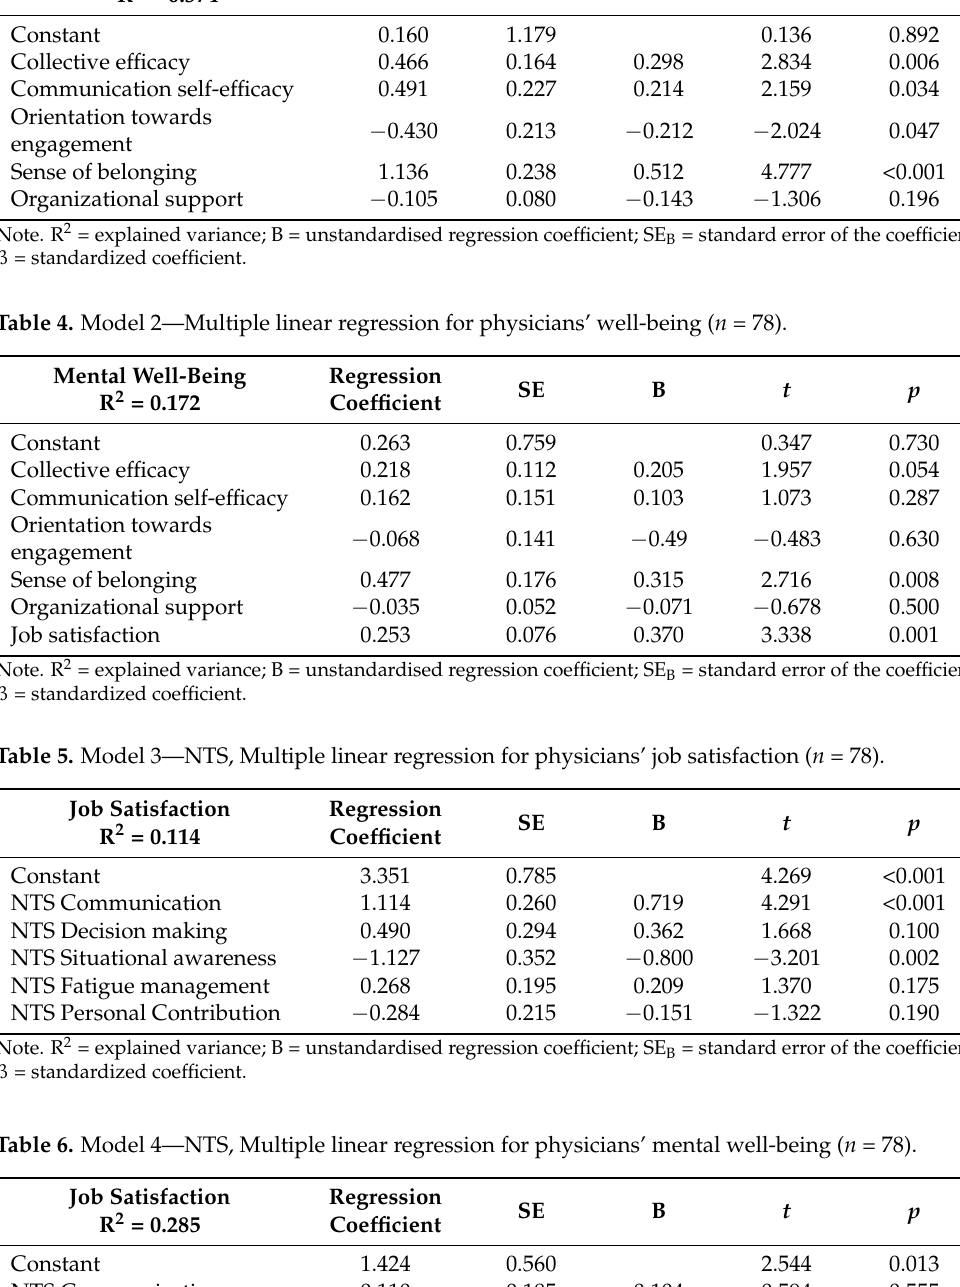
Table 3. Model 1—Multiple linear regression for physicians’ job satisfaction ( n = 78).